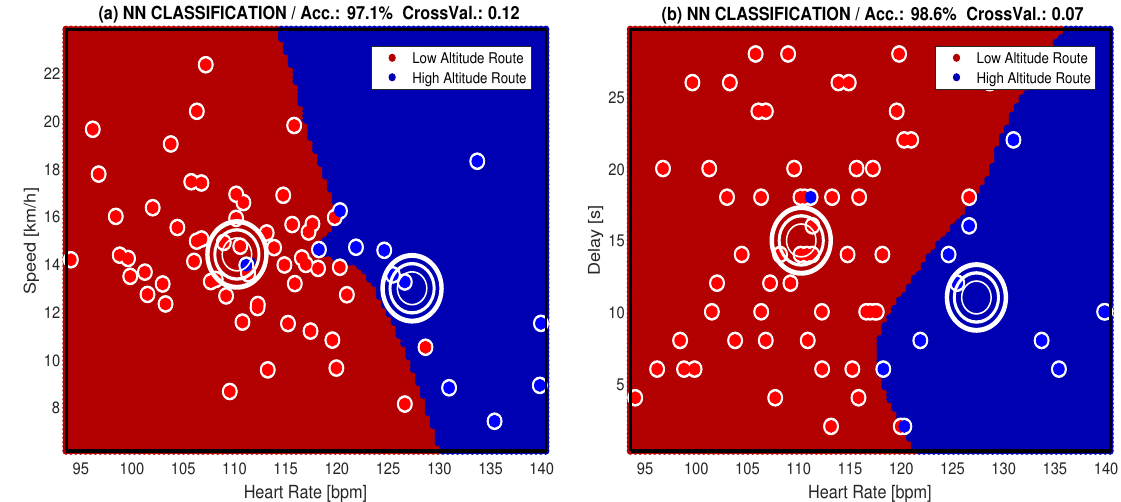
Figure 8. Neural networks (NN) classification of 10-min segments for uphill cycling into two separate classes ( c 1 —mean altitude less than 1500 m and c 2 —mean altitude greater than 1500 m) and the mean heart rate related to ( a ) the mean speed and ( b ) the delay in the change in the heart rate vs. gradient of altitude presenting centers of gravity of class features.